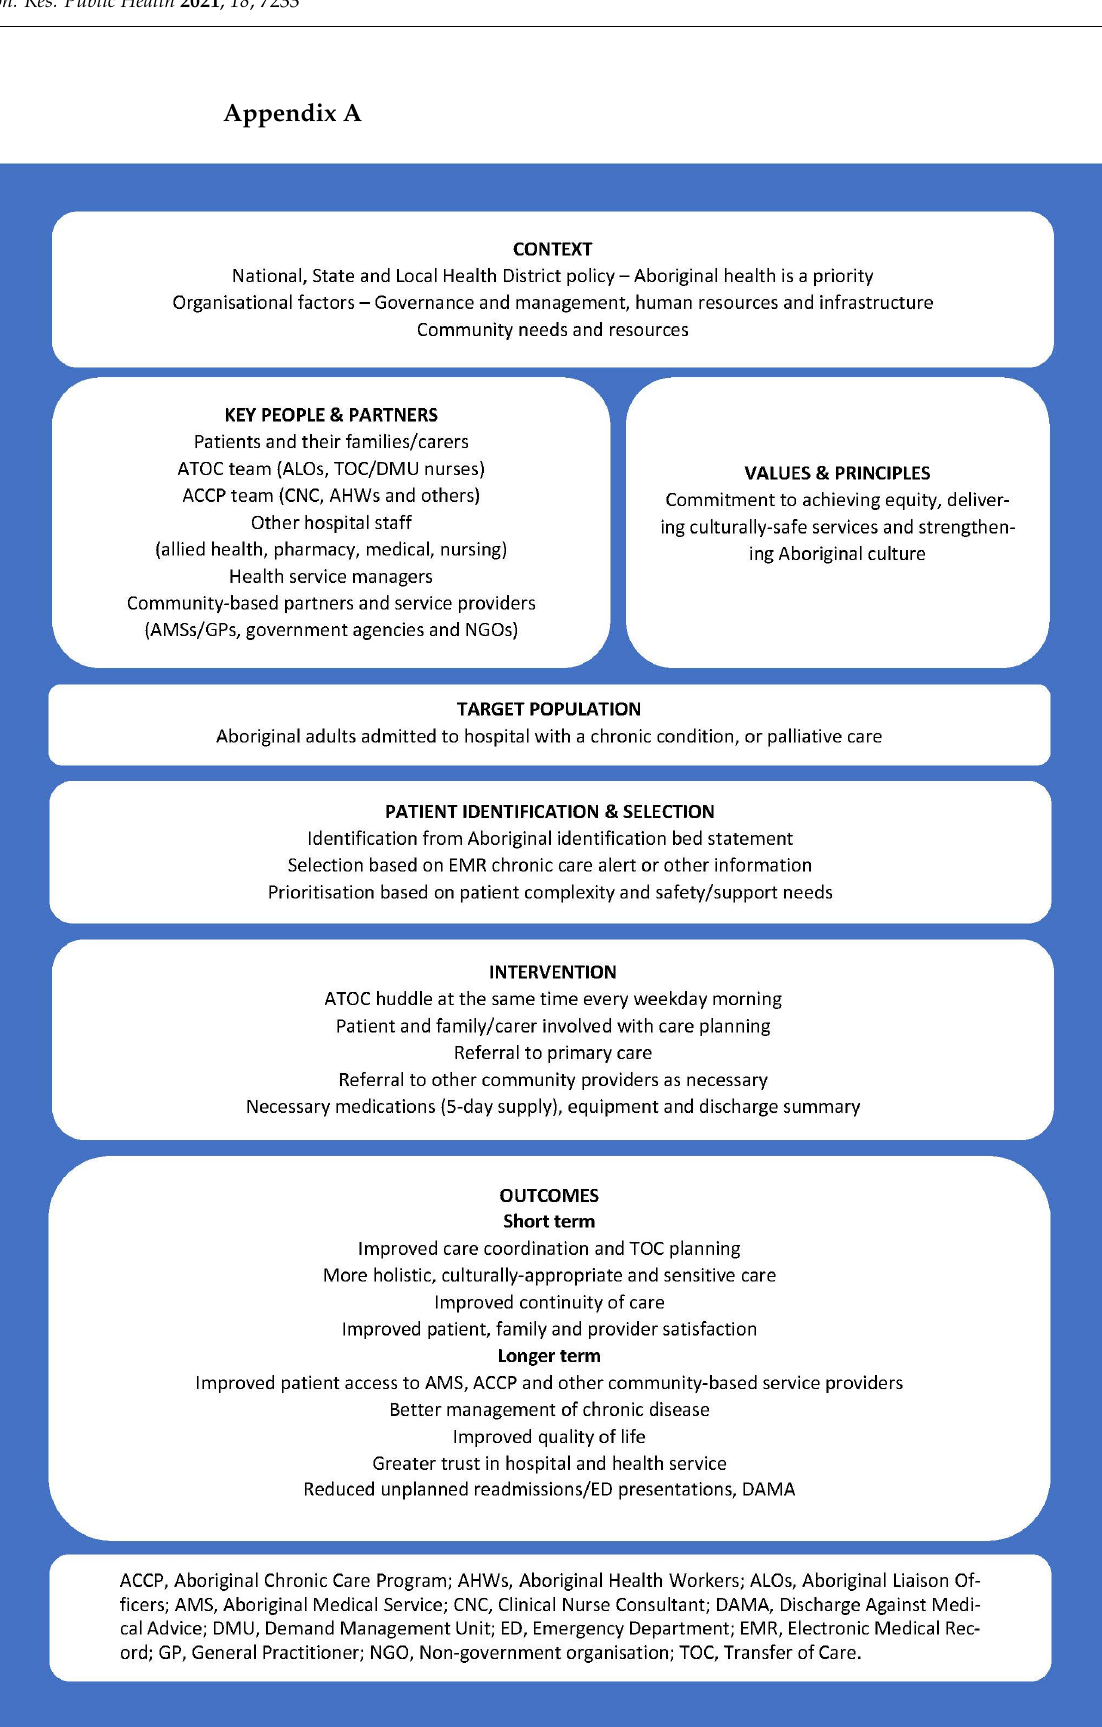
Figure A1. Program logic underpinning the ATOC model .